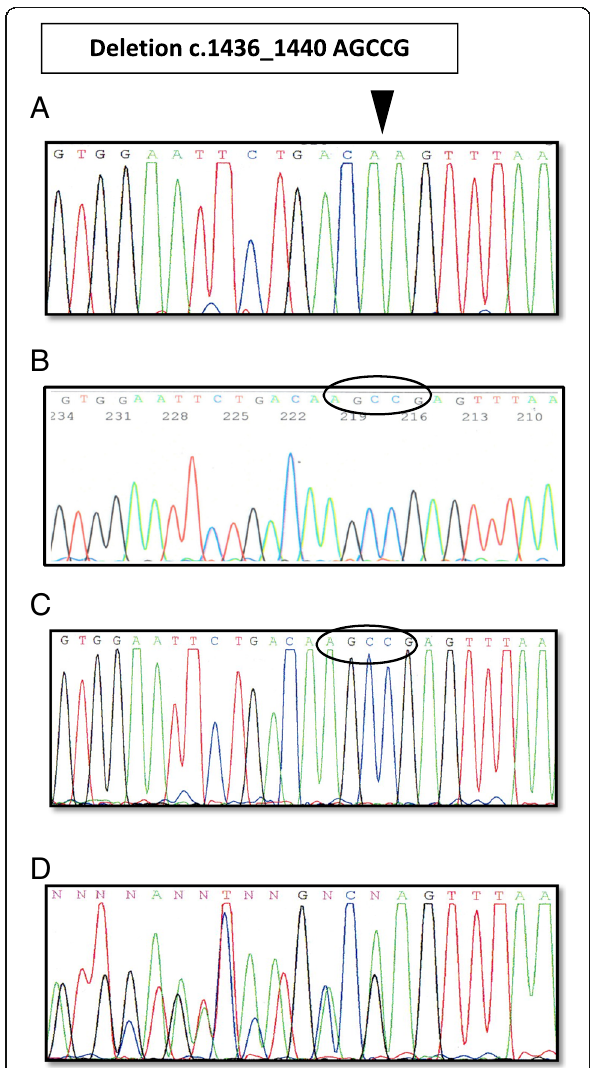
Fig. 2 The results of direct sequencing by Sanger. The Fragment of exon 9 of the IDS gene: a ) the proband: deletion p.1436_1440 AGCC G in the “ homozygous ” state; b ) normal sequence according to reference NM_000202.5; c ) the father: a normal variant of the sequence of the IDS gene; d ) the mother: deletion p.1436_1440 AGCCG in the heterozygous